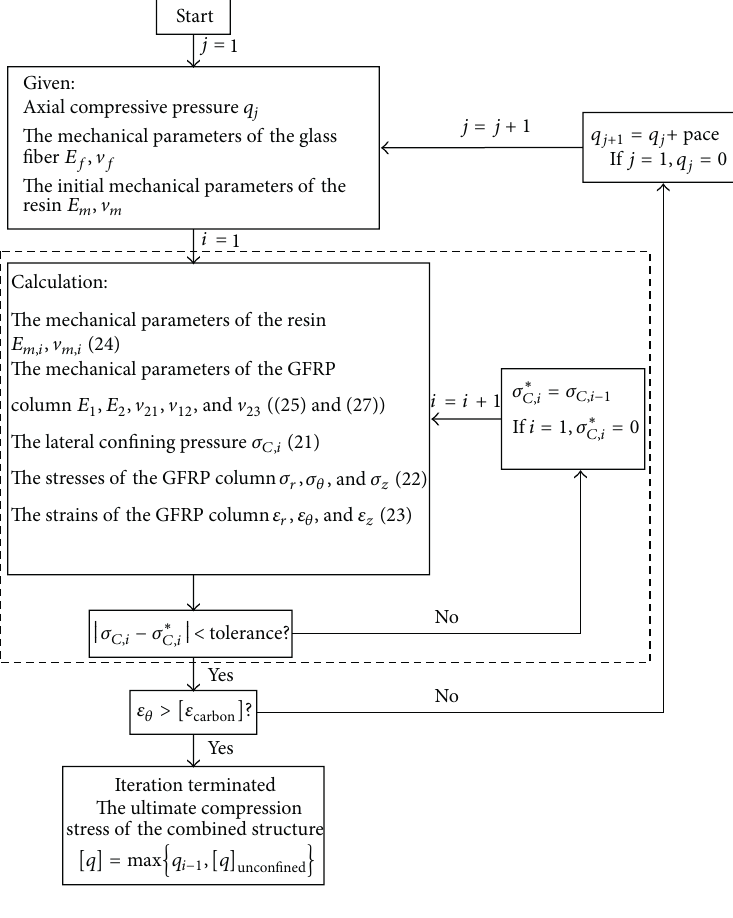
Figure 4: Iterative calculation process for the ultimate compressive stress of the CFRP sheet confined GFRP short pipe. Table 3: Comparison between the experimental and the theoretical results of the ultimate axial compressive stress. Specimen